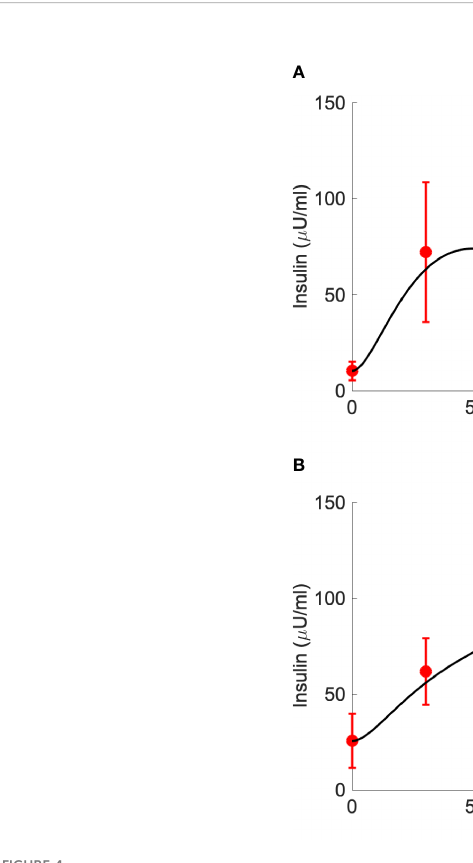
FIGURE 4 Best- fi t results for model validation on reference mean experimental data by Karusheva et al. (7) for glucose-tolerant participants (CNT, n=10, panel A ) and patients affected by type 2 diabetes (T2D, n=10, panel B ). Red circles are the reference experimental values (mean ± SD); black lines are the model